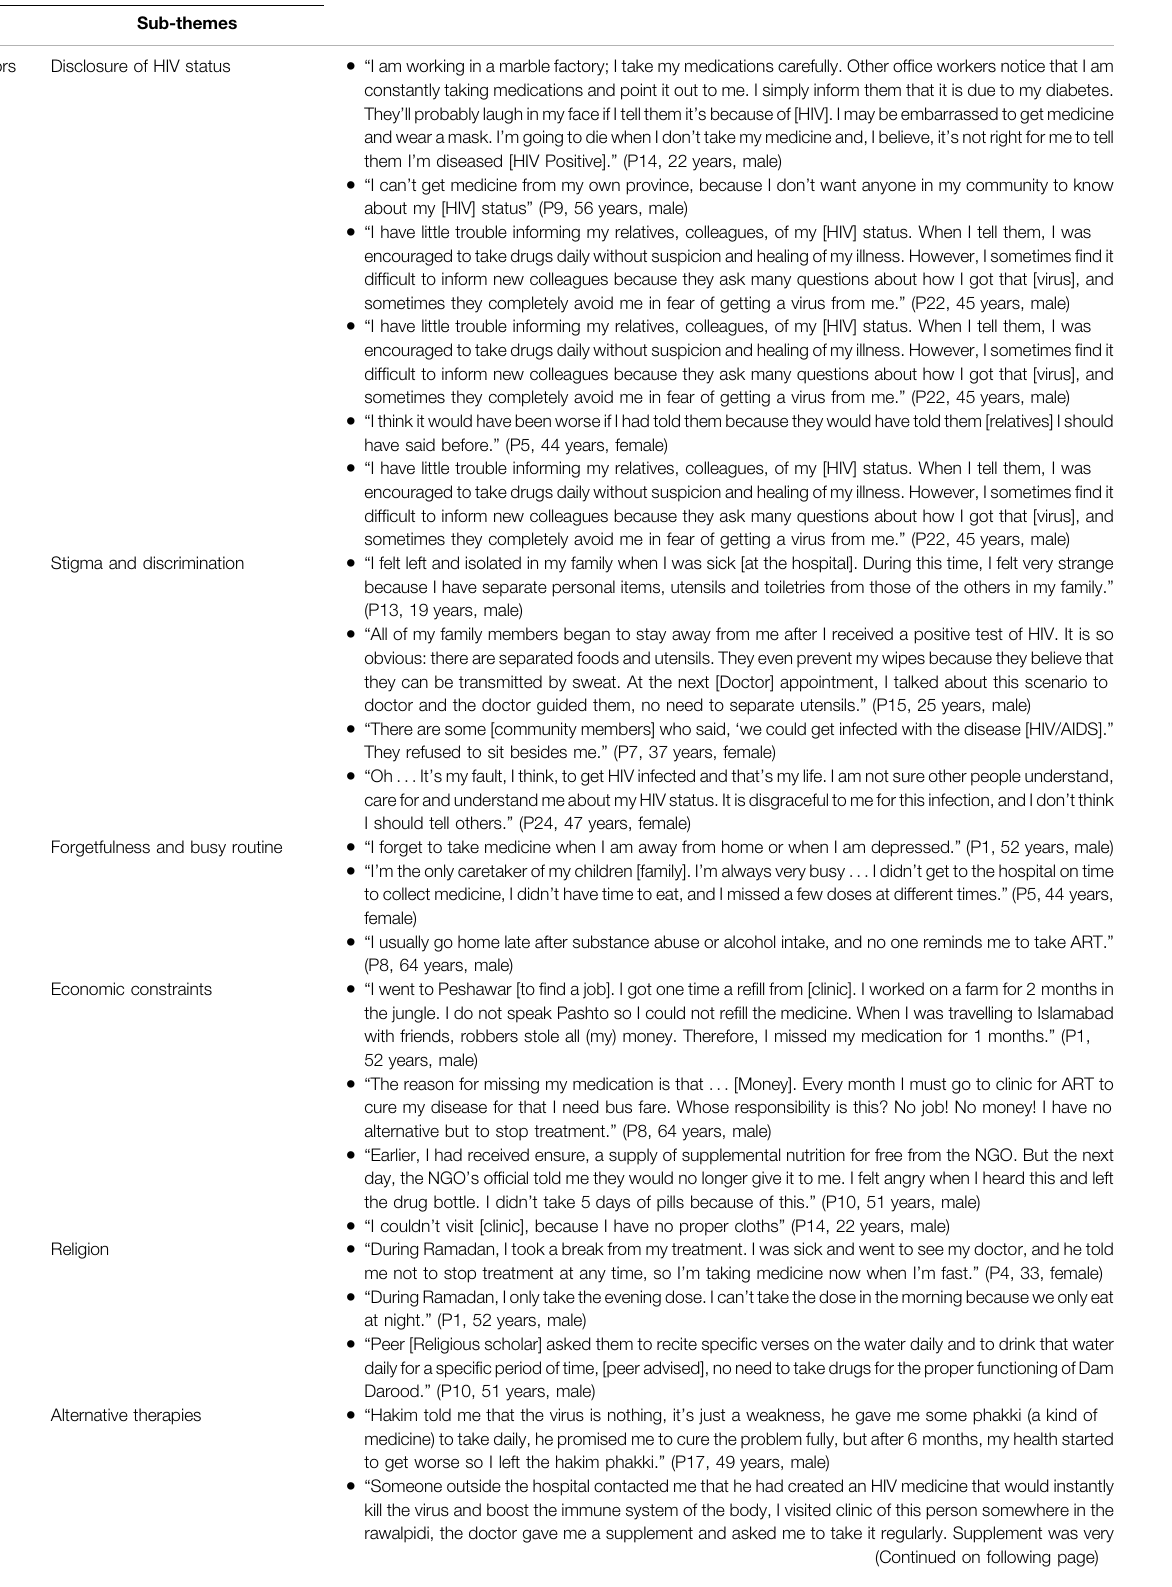
TABLE 2 | Barriers to retention in HIV care for people living with HIV in Pakistan.